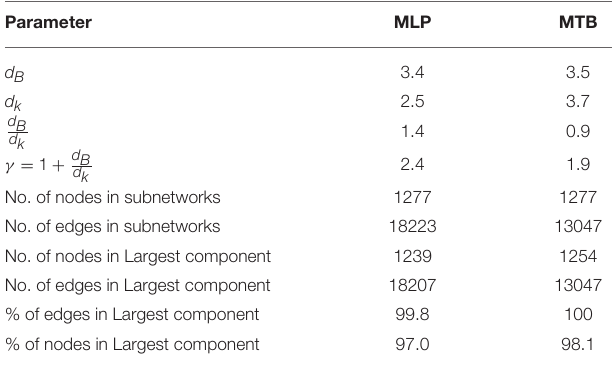
TABLE 3 | Subnetwork topologies computed using the largest connected